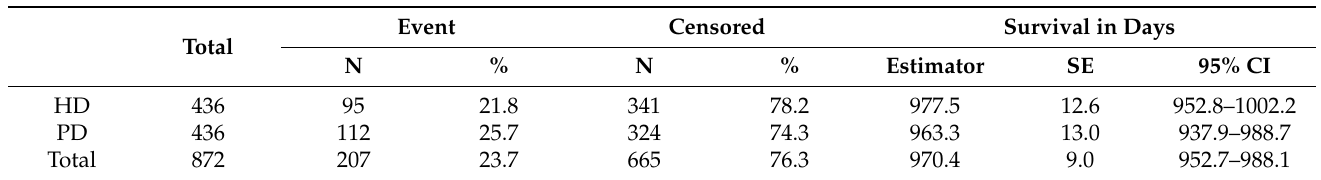
Table 3. Survival data.